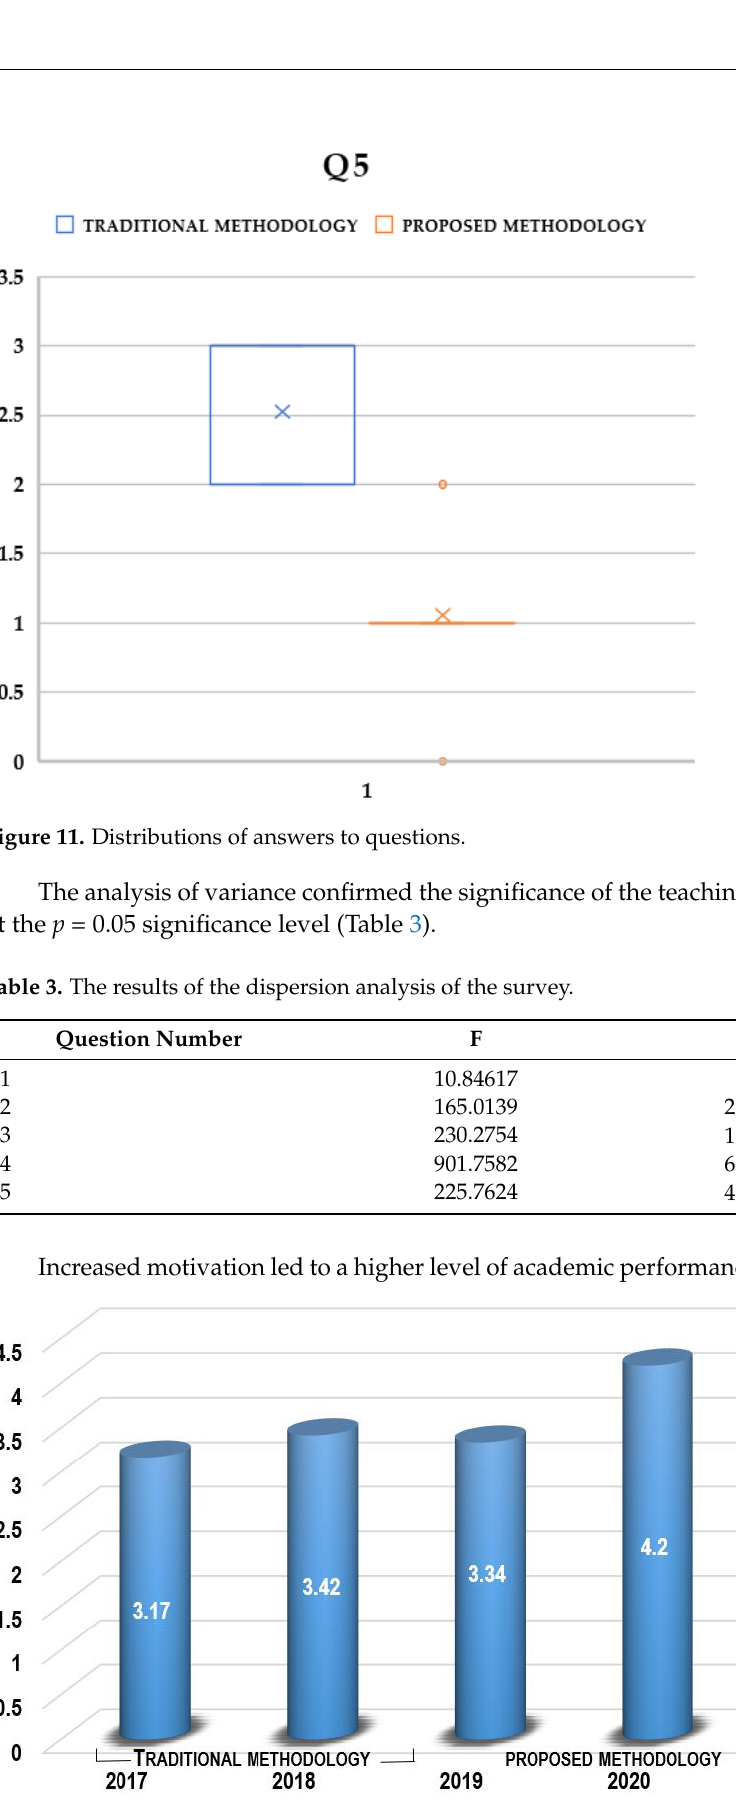
Figure 12. Exam results — average score obtained by students.